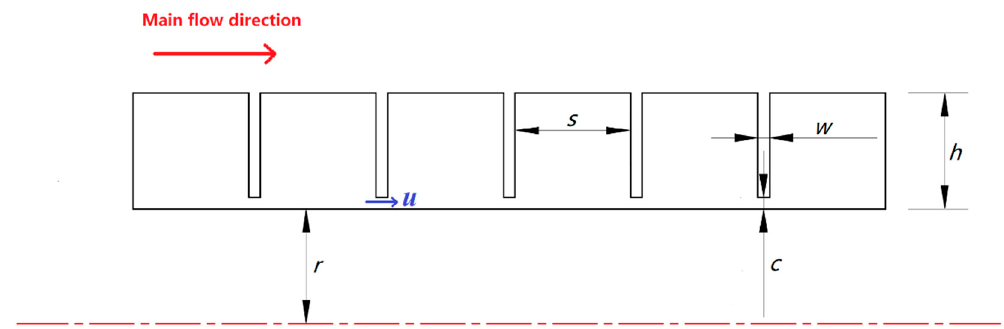
Figure 1. The essential structure of the labyrinth seal.